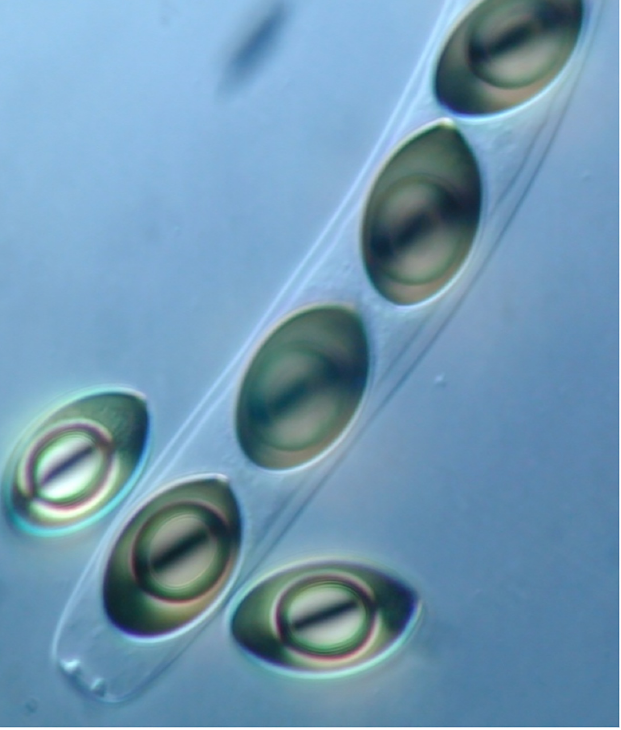
Fig 2. The sexual state observed both after passage through a sheep, and after infection of a B . tectorum plant. Ascospores, the products of meiosis, within and outside an ascus of S . fimicola CID